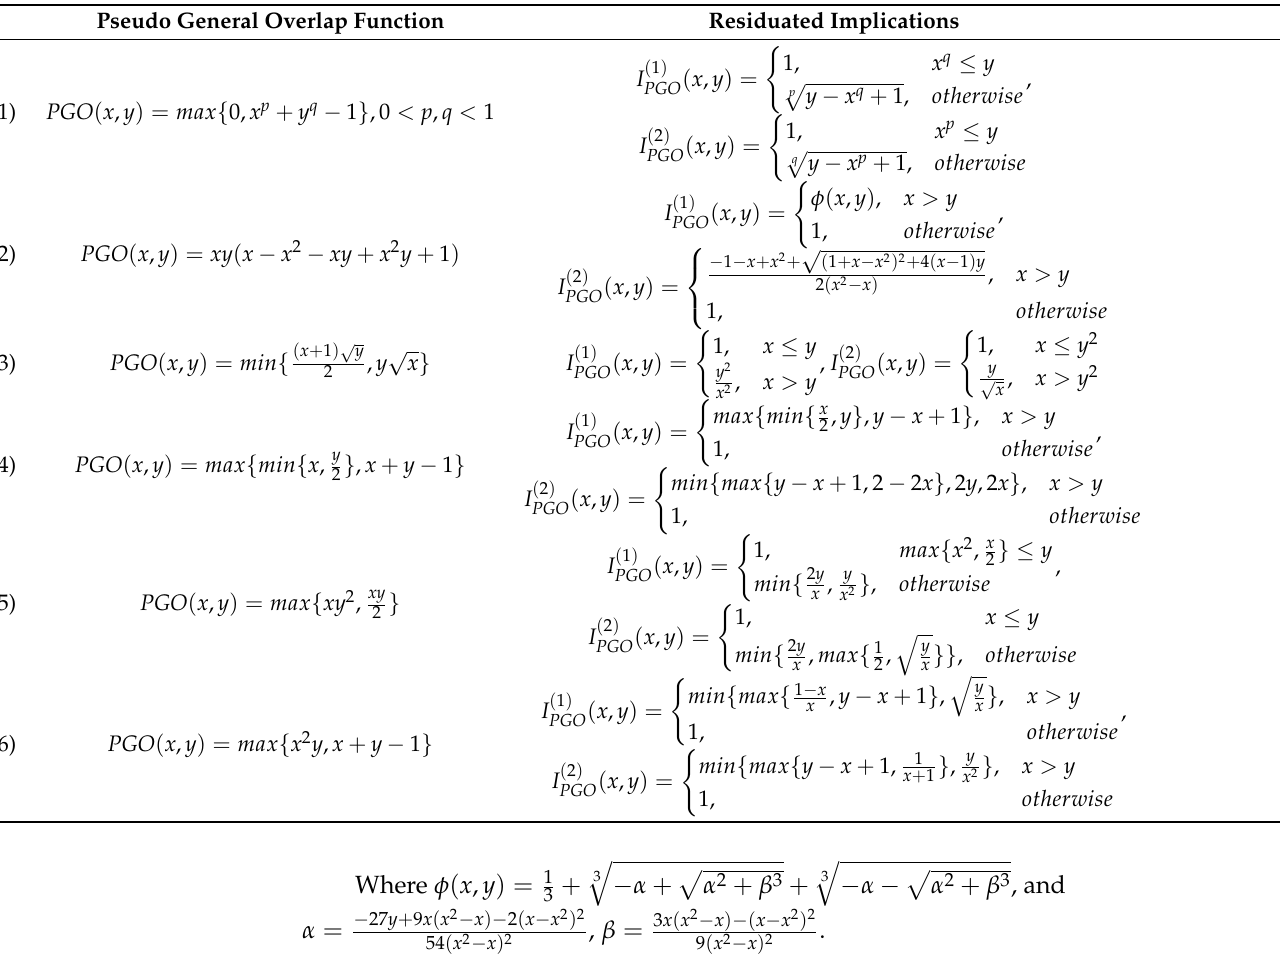
Table 1. Pseudo general overlap functions and their residuated